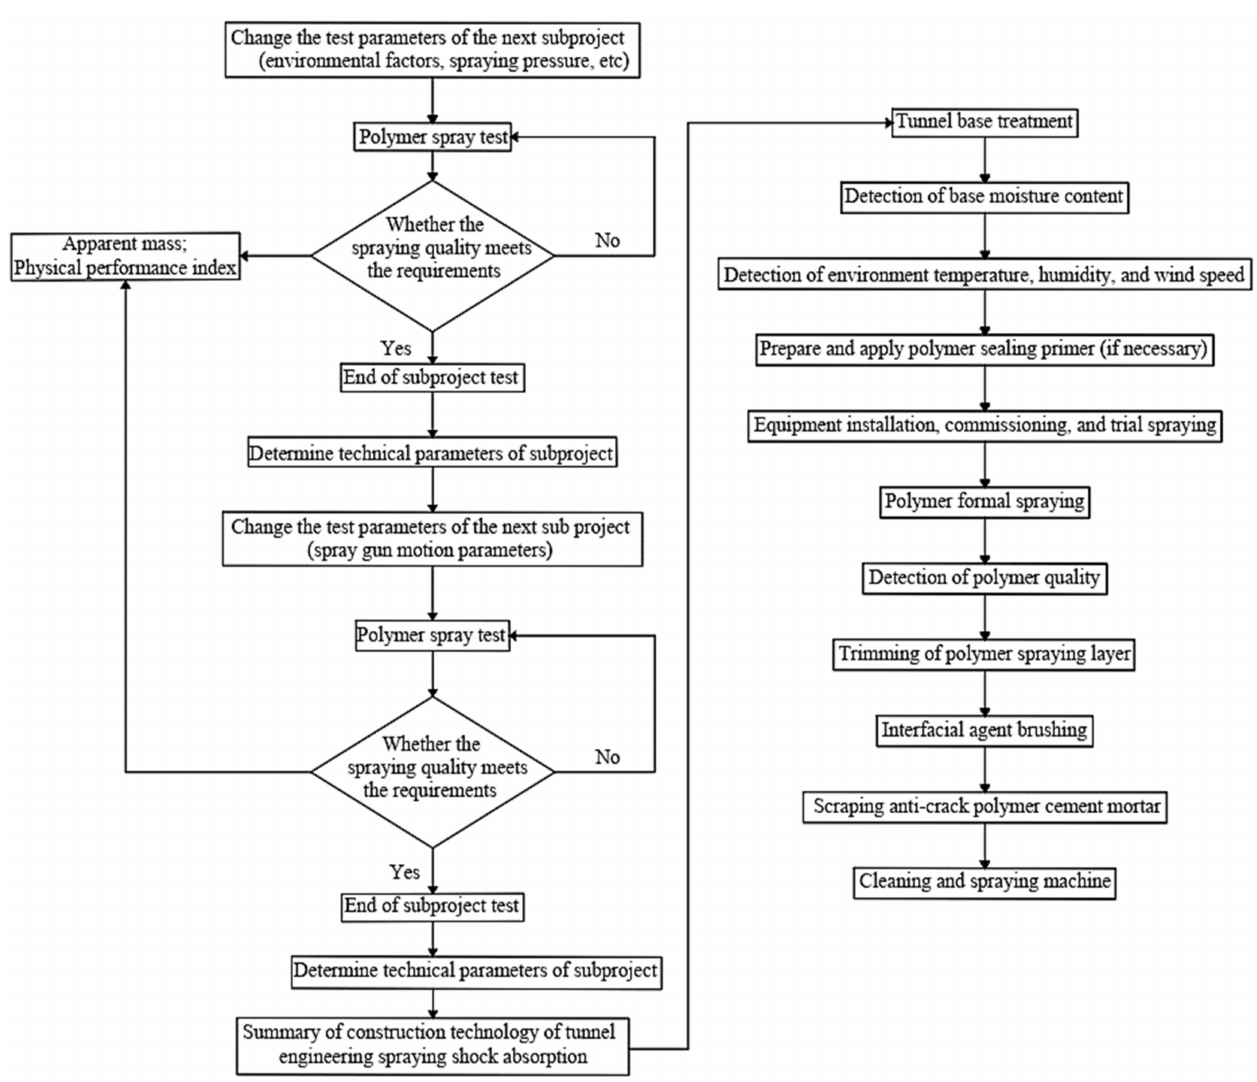
Figure 3. Spraying test process and sequence of each sub-project and construction process of polymer spraying